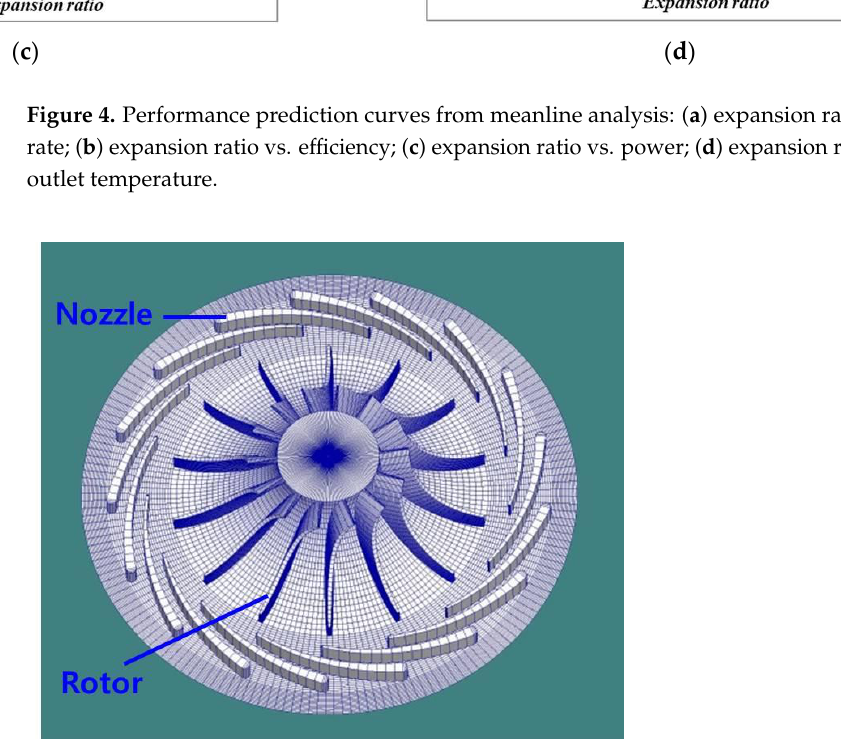
Figure 5. Generated 3D geometry of nozzle and rotor.